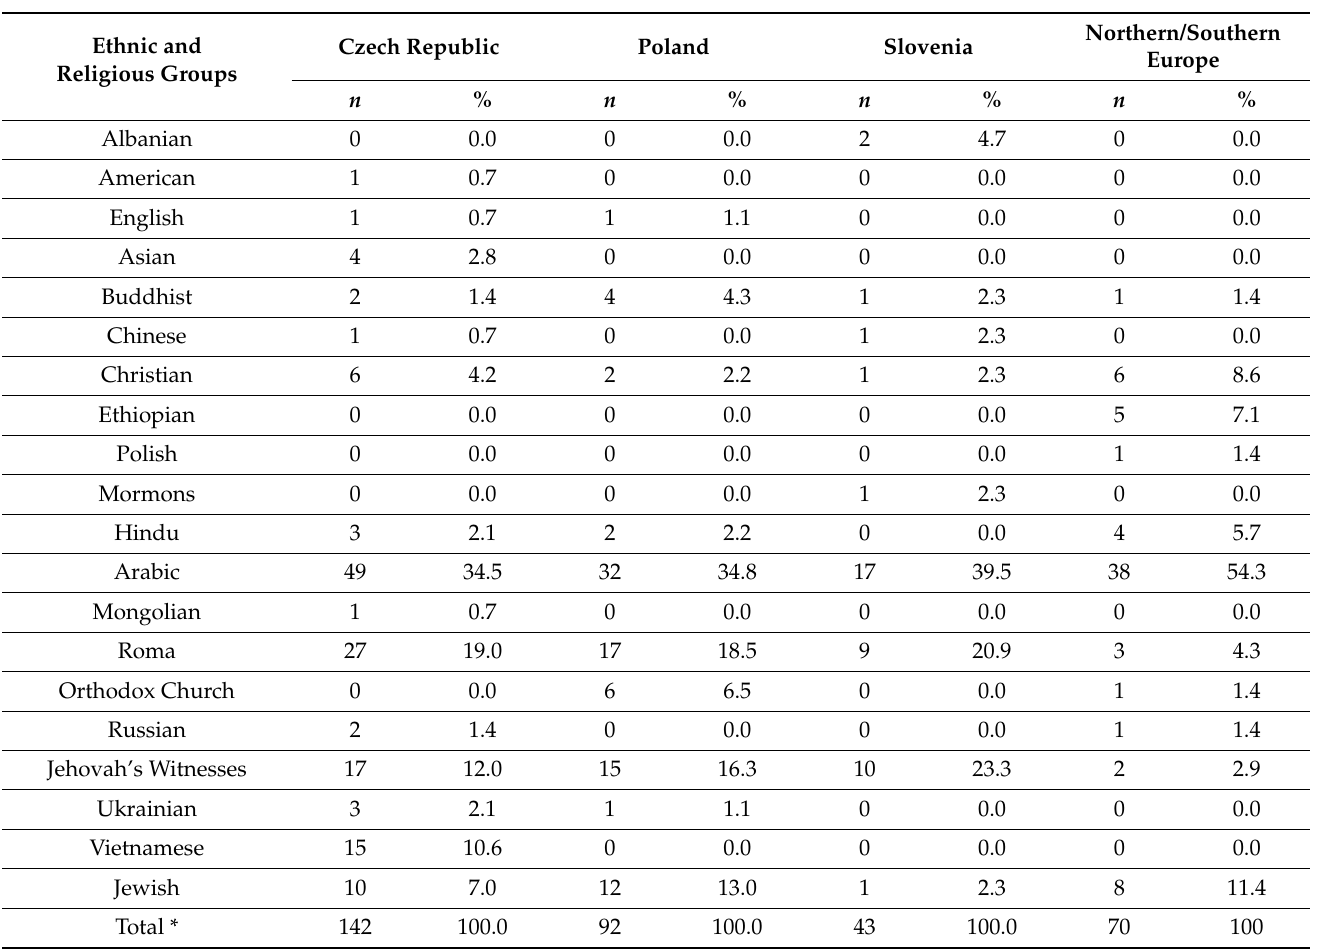
Table 4. Ethnic and religious groups indicated by ICU nurses that they would like to get to know better.